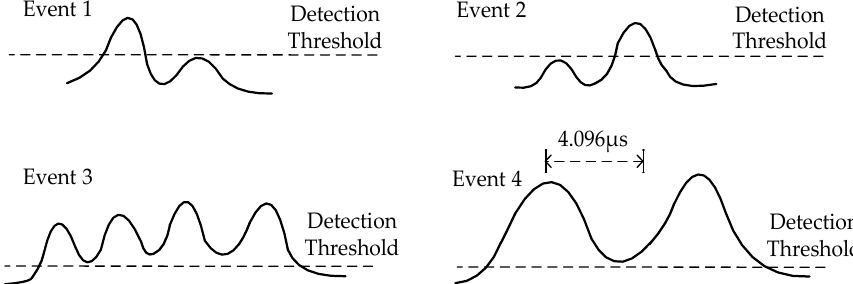
Figure 5. Complicate events which analog circuits cannot handle. In events 1 and 2, when the signal from a small particle cannot remain above the threshold, only one crest is detected, and no time-of-flight measurements are taken. In the case of event 3, although the signal remains above the threshold, three or more crests are detected as a result of coincidence. Such events are logged, but concentration and flight time are not recorded. Event 4 is outside the timer’s maximum range, and in this case, the signal re-mains above the threshold until it moves outside the timer’s range, and only one crest is observed. Event 4 is typically caused by large or recirculating particles, and in this case, the event will be logged, but no time-of-flight is recorded.